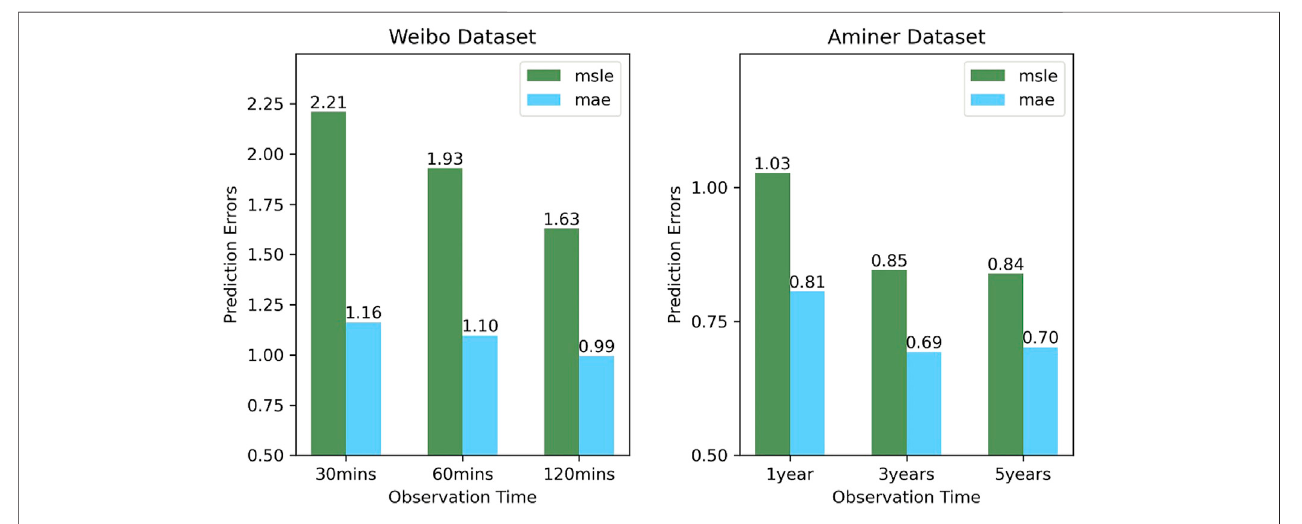
FIGURE 2 | Prediction results under different observation times